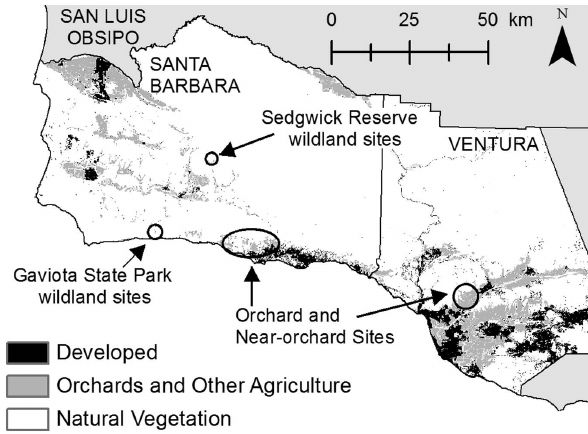
Figure 1. Study area in southern California. Study sites within Santa Barbara and Ventura counties.